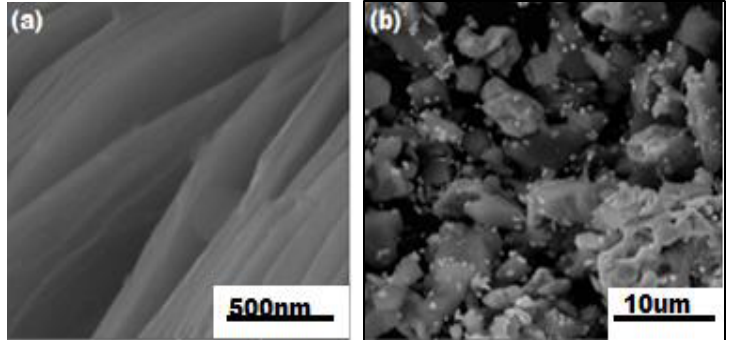
Figure 2. Images obtained from SEM of ( a ) MXene (Ti 3 C 2 T x ), ( b ) MXene/Ag 2 CrO 4 nanocomposite.